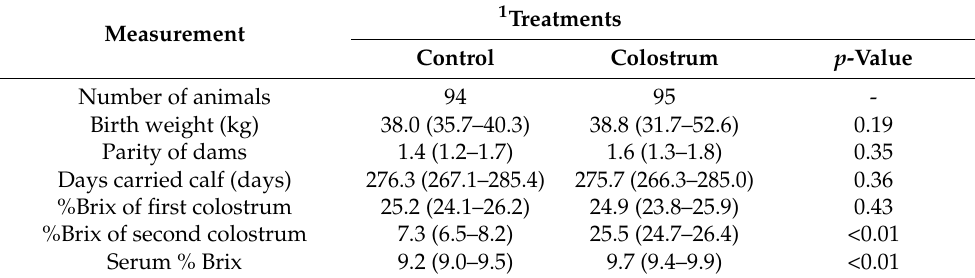
Table 1. Description of the study population and treatment are presented as total counts and 95% CI.